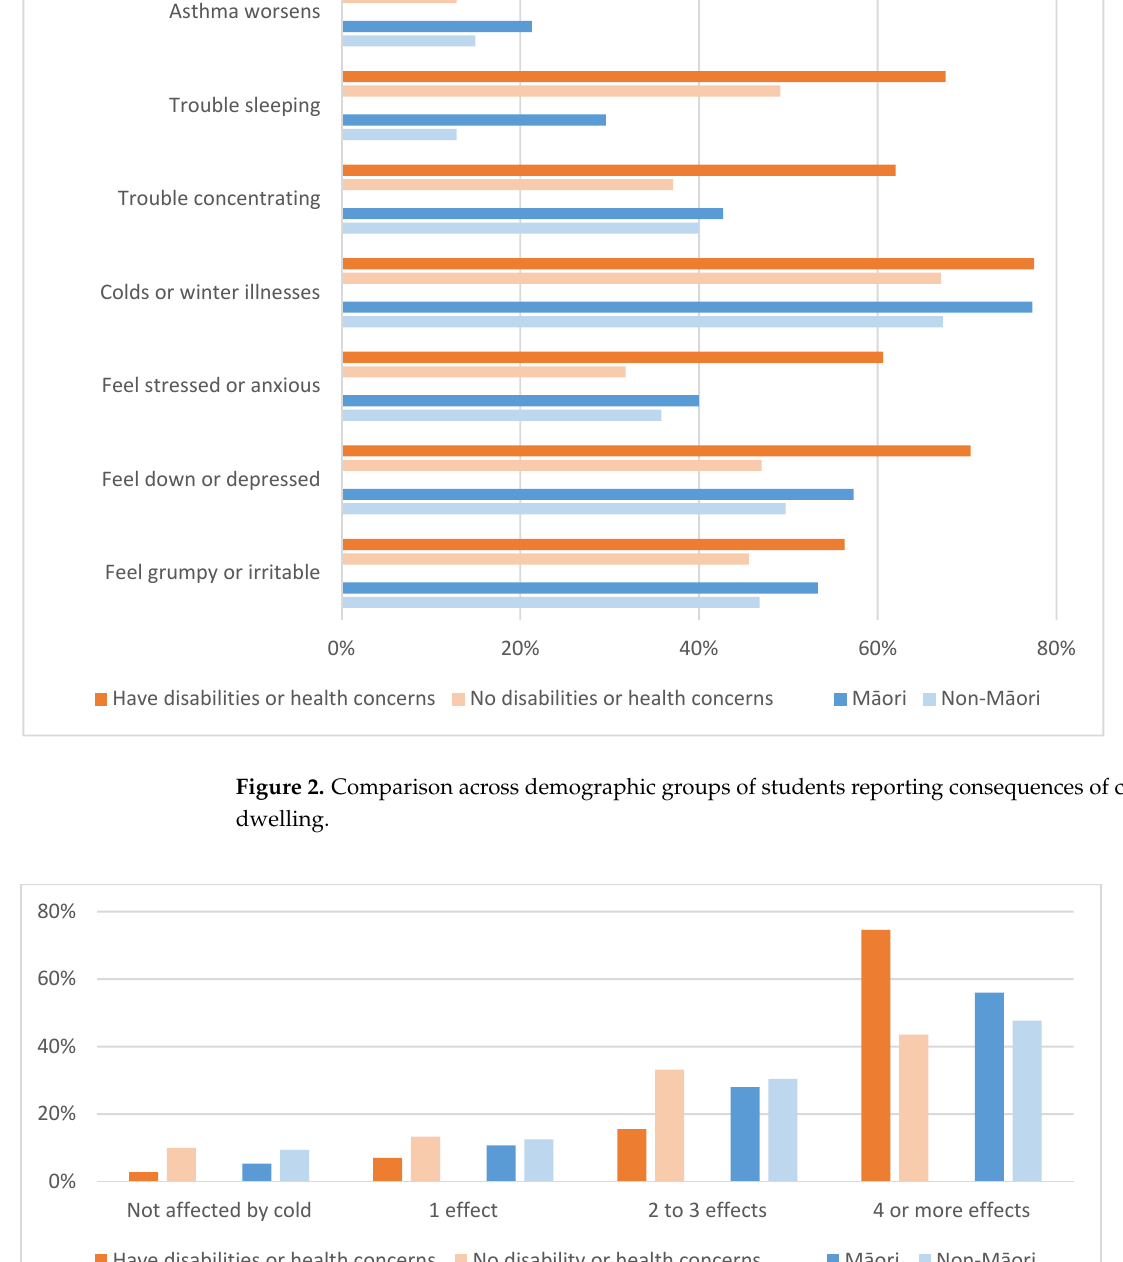
Figure 3. Comparison of the number of effects experienced from being cold in the dwelling.